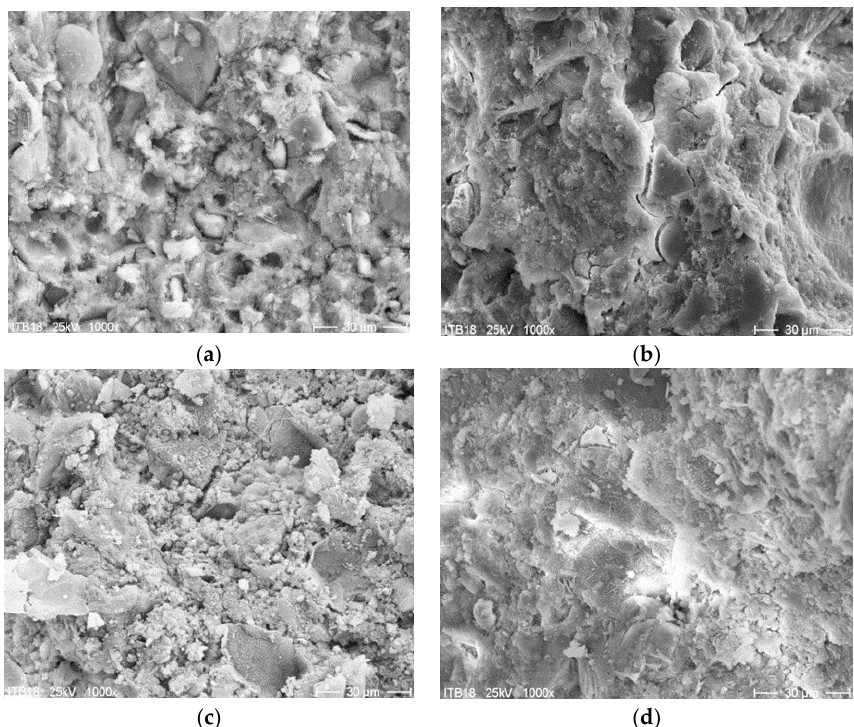
Figure 6. SEM image of fracture of mortar II sample cured at 21 ◦ C (( a )–after two days of curing, ( b )–after 28 days of curing) and 8 ◦ C (( c )–after two days of curing, ( d )–after 28 days of curing); 1000× magnification.